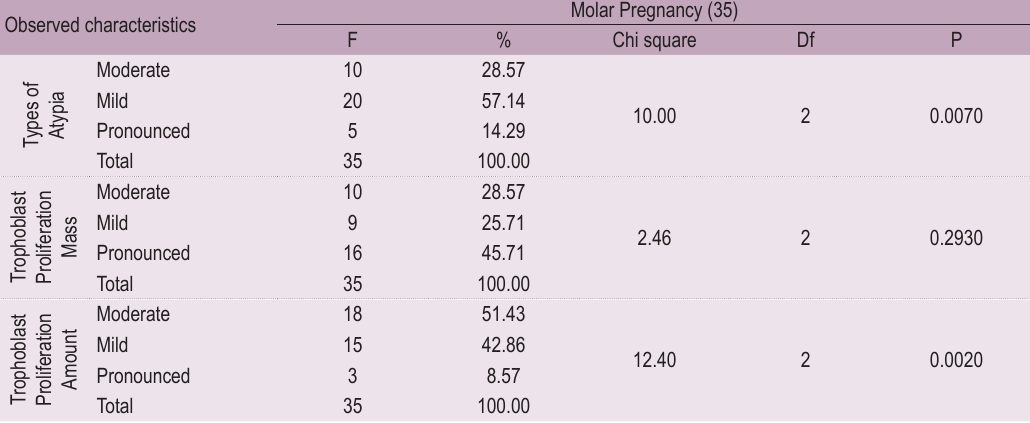
TABLE 2. Number and Characteristics of Pregnant Women according to Pathomorphologic Trophoblast Observed characteristics